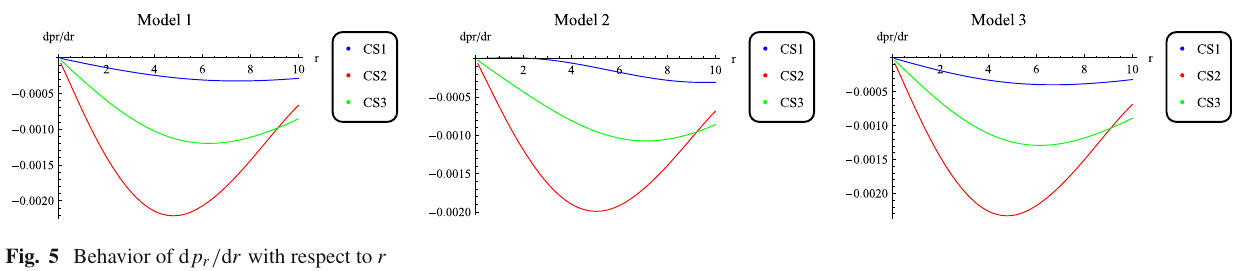
Fig. 5 Behavior of d p r / d r with respect to r